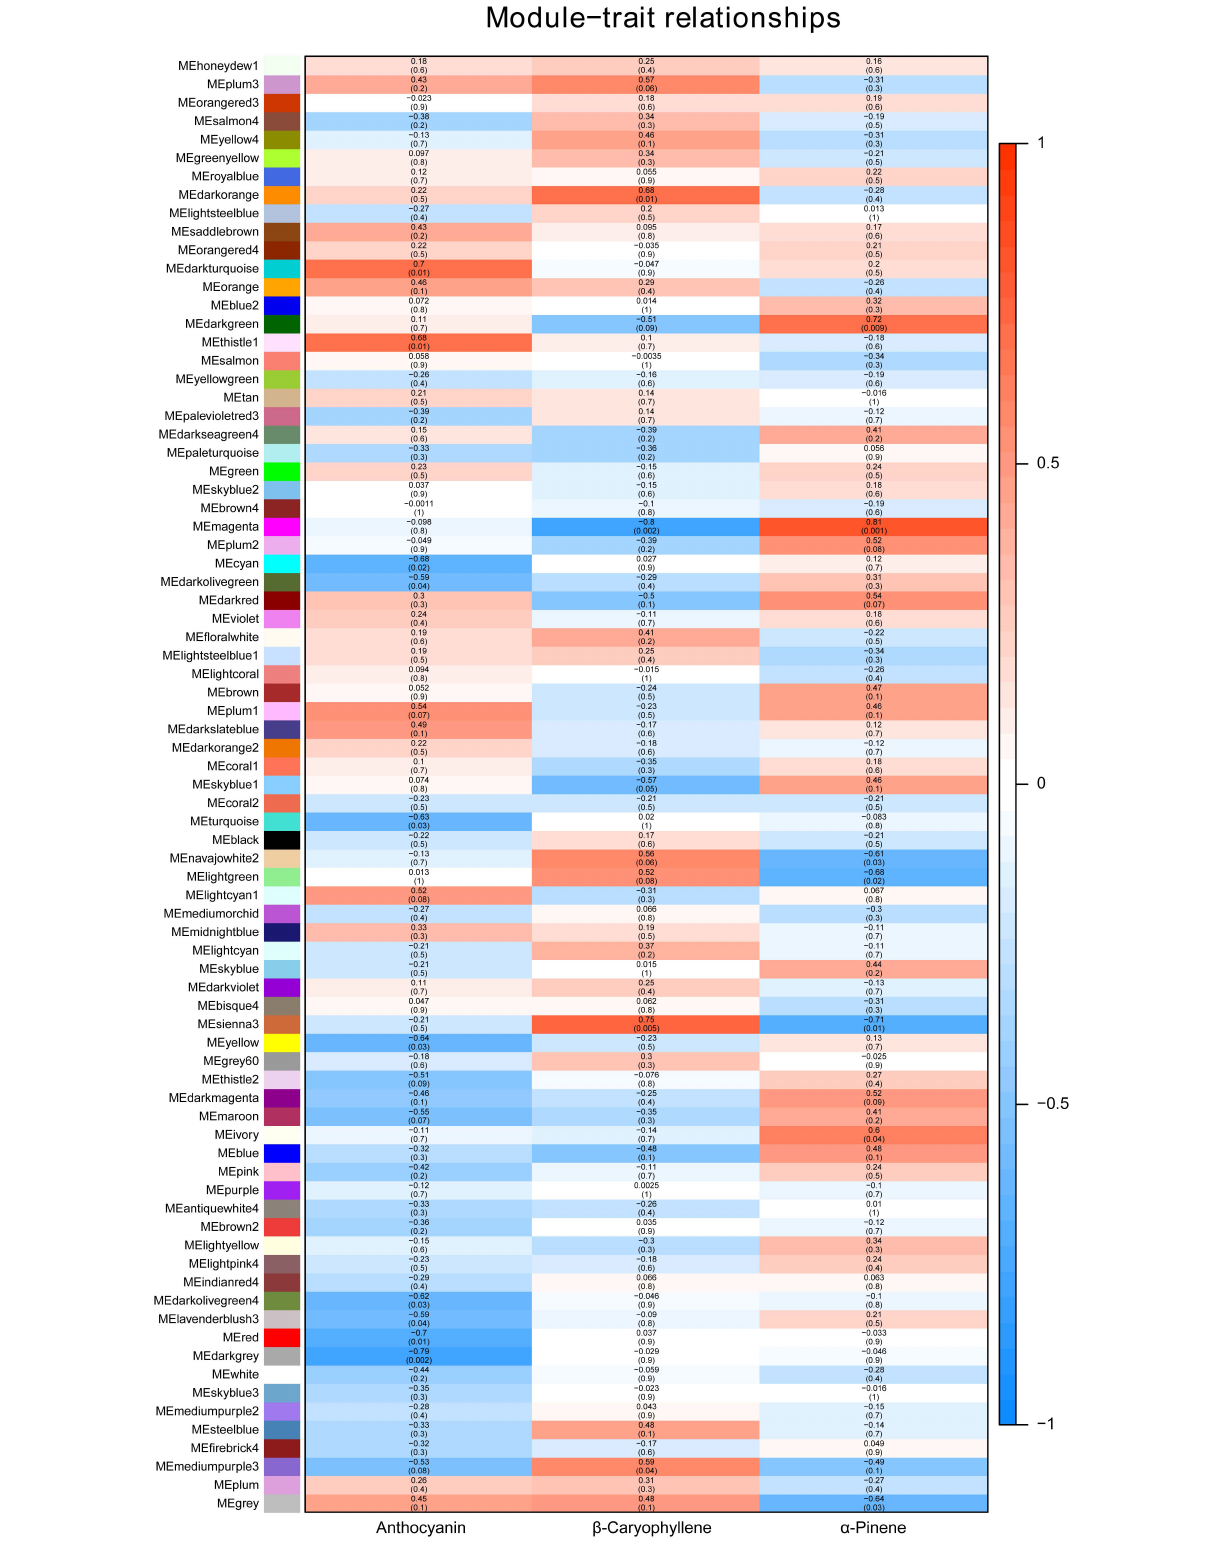
Frontiers in Plant Science |